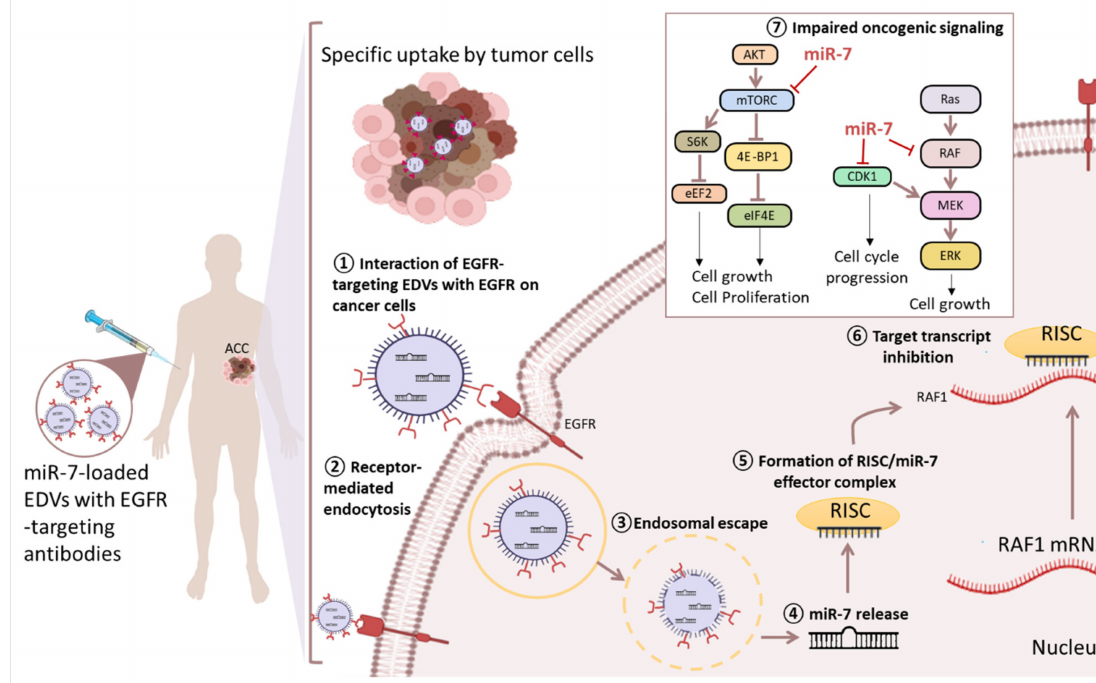
Figure 3. A proposed model in which miR-7 replacement via EDVs (EnGeneIC Delivery Vehicle) in Adrenocortical Carcinoma could inhibit multiple oncogenic pathways including mTOR, MAPK and CDK1 signaling pathways [70]. mTORC: mammalian target of rapamycin Complex; 4EBP1: eukaryotic translation initiation factor 4E- (eIF4E-) binding protein 1; eIF4E: eukaryotic translation initiation factor 4E; S6K: ribosomal protein S6 kinase; eEF2: eukaryotic elongation factor 2; CDK1: cyclin dependent kinase